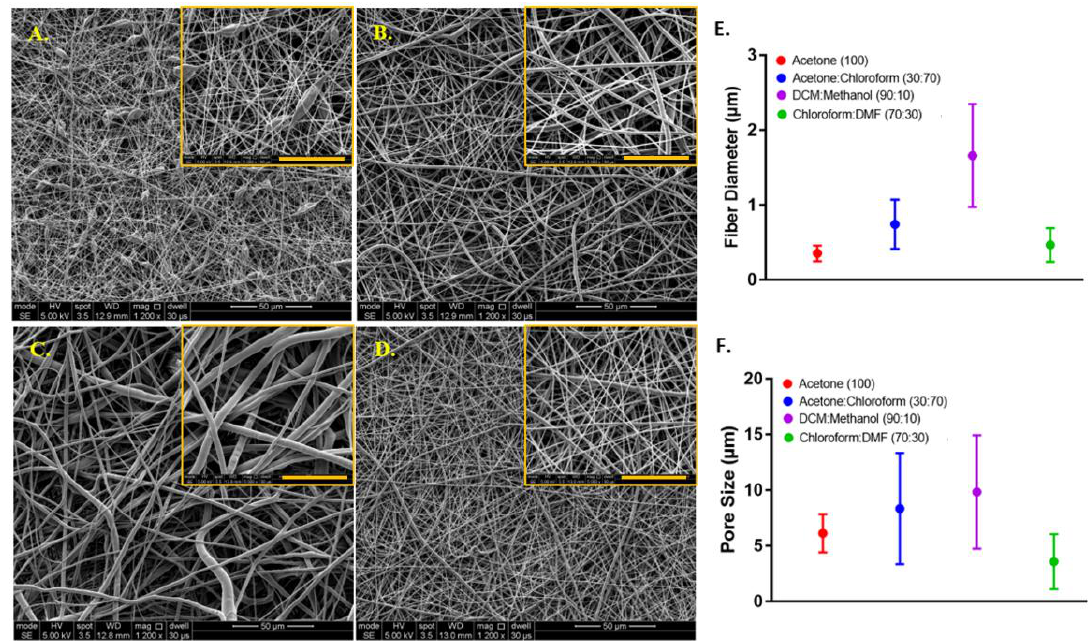
Figure 6. Morphological characterisation of the electrospun PCL fibres, where polymer solutions were prepared with di ff erent solvents. SEM image of PCL electrospun prepared by dissolving PCL in ( A ) acetone (100), ( B ) acetone:chloroform (30:70), ( C ) dichloromethane (DCM):methanol (90:10), ( D ) chloroform:dimethylformamide (DMF) (70:30). The graphs show ( E ) the fibre diameter and ( F ) the pore size distributions, respectively. Yellow scale bars represent 20 µ